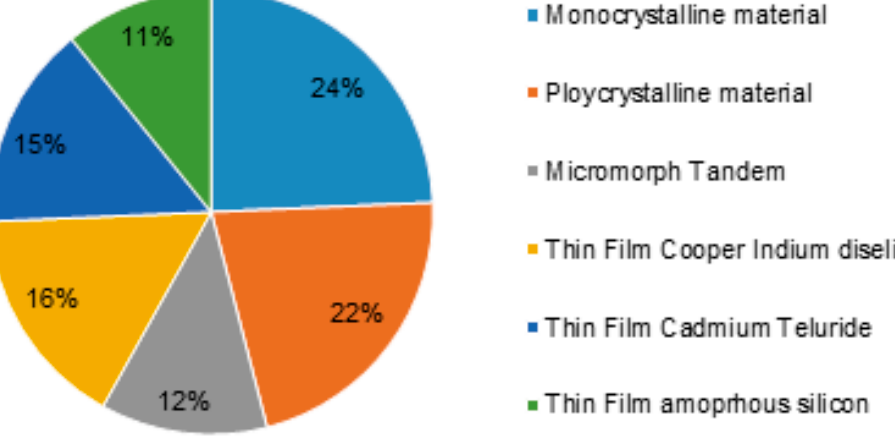
Figure 1. Efficiency of material used in energy conversion.